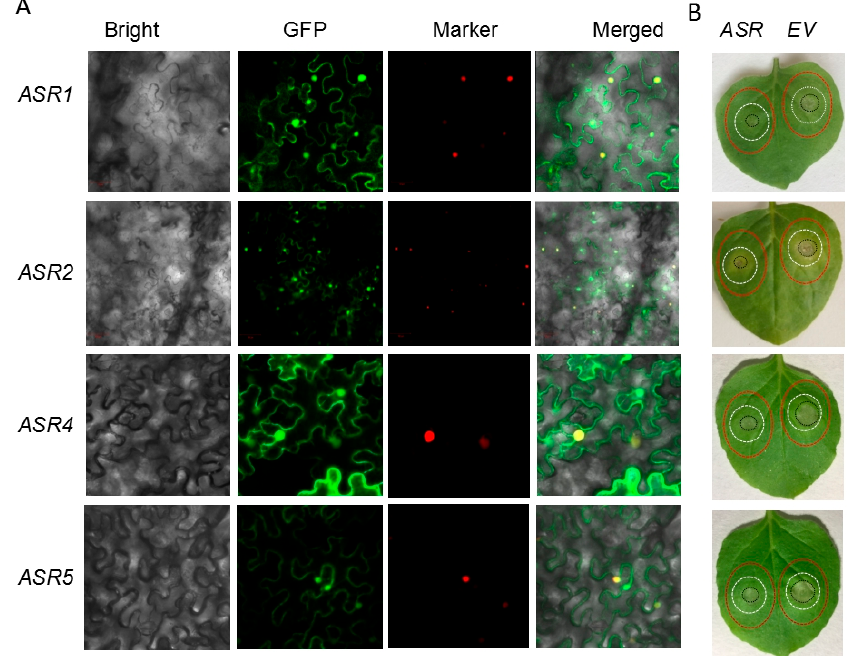
Figure 4. Subcellular localization and Cd ‐ tolerance assay of GFP ‐ tagged ZmASR fusion proteins in N . benthamiana . ( A ) Subcellular localization of GFP and the ZmASR ‐ GFP fusion protein in N. benthamiana leaf cells. Epidermal cells of N . benthamiana leaves transiently expressing GFP fusion proteins were observed using confocal microscopy at 4 days post Cd infiltration. RFP ‐ H2A, localized in the nucleus, was used to indicate the nuclei [41].( B ) Lesions were photographed at 4 days post Cd treatment. The EV transformed control region is on the right, while region transient expressing ZmASR is on the left for each leaf. Agro ‐ infiltrated areas are indicated by red circles and Cd ‐ infiltrated areas are circled by the smaller white lines, whereas Cd ‐ caused lesions are indicated by the internal black circles on each leaf.